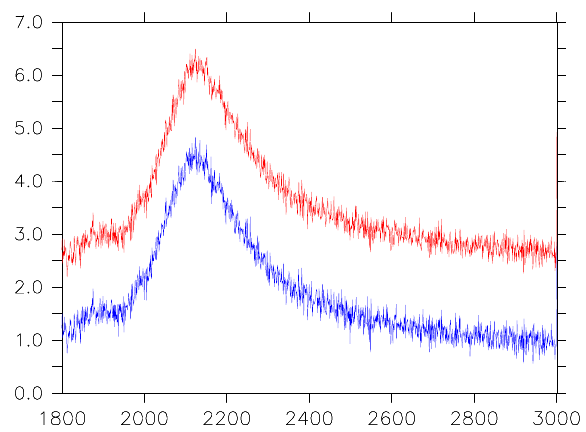
Fig. 25. The annual global mean TOA net radiation budget (red) and surface heat budget (blue) in Wm − 2 in the scenario run.